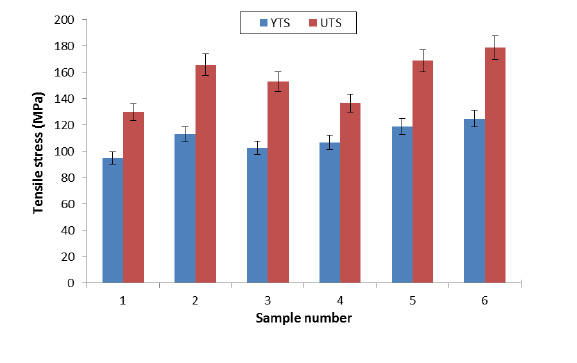
Figure 12: Variation of yield and ultimate tensile strength for all composites.